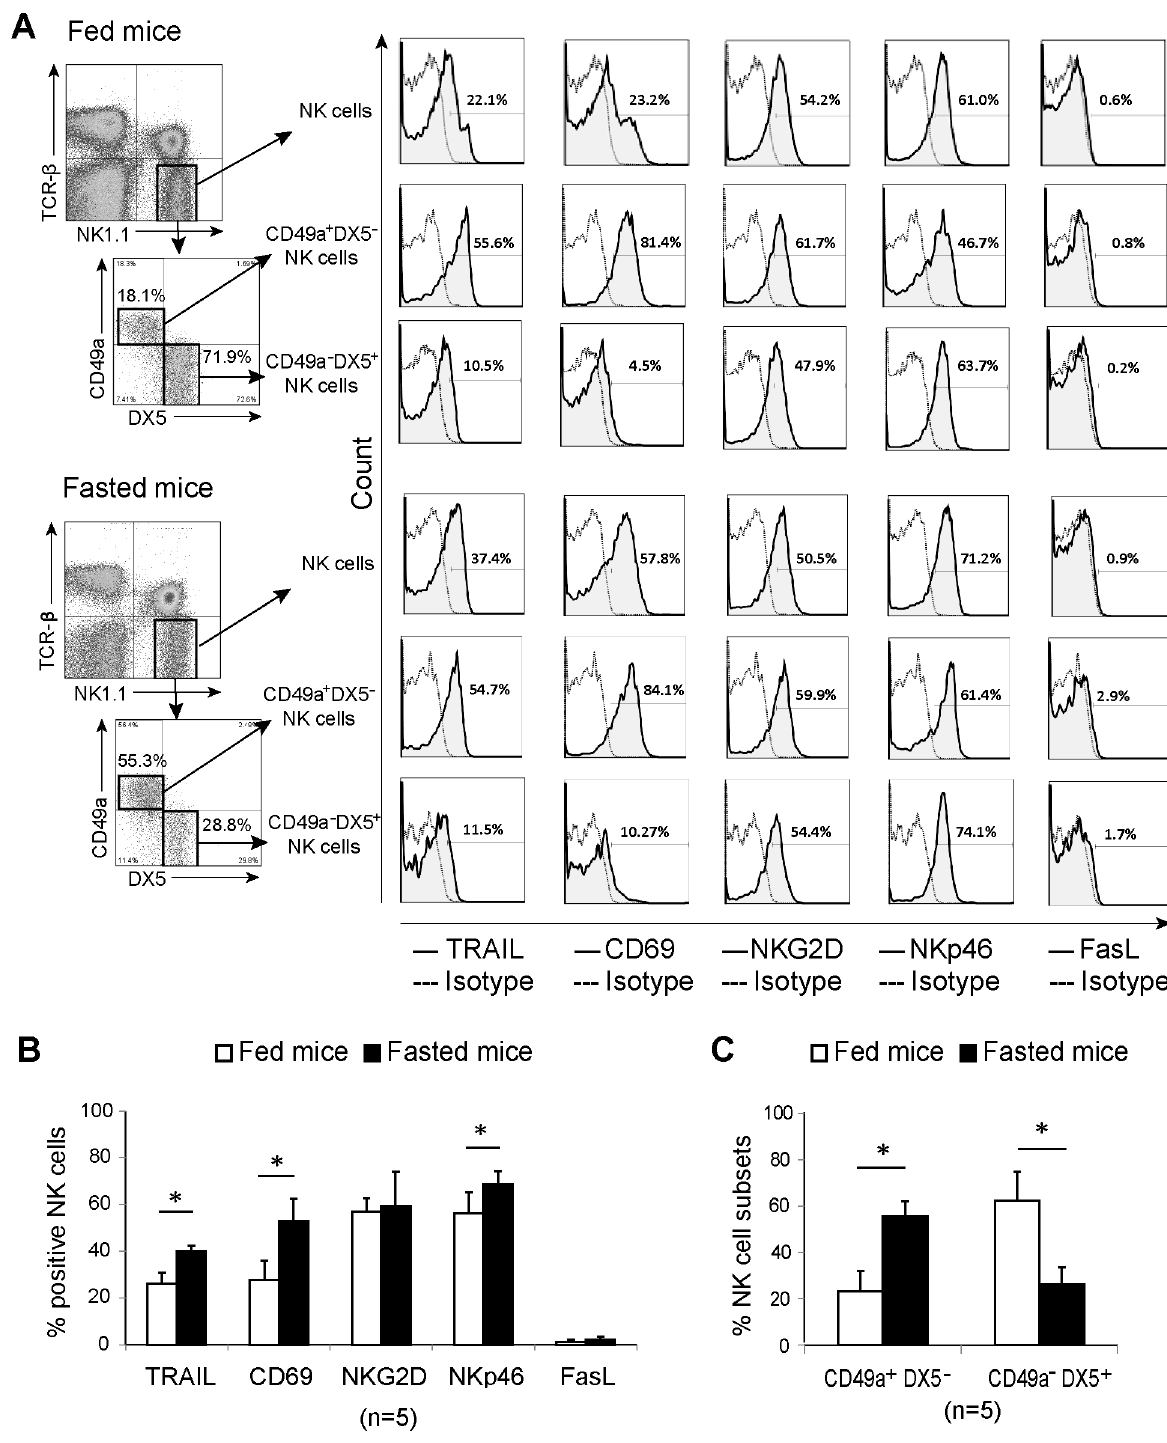
Figure 3. Analysis of functional markers in liver natural killer cells and their CD49a + DX5 2 and CD49a 2 DX5 + subgroups. Liver lymphocytes from fed and 3-day-fasted mice were simultaneously stained with monoclonal antibodies against DX5, CD49a, TRAIL, CD69, NKG2D, NKp46, and FasL. (A) Representative dot plots of gated TCR b 2 NK1.1 + natural killer (NK) cells and its two subsets, CD49a + DX5 2 and CD49a 2 DX5 + NK cells, in fed and fasted mice are presented. Histograms show the expression of TRAIL, CD69, NKG2D, NKp46, and FasL (solid lines) on whole NK cells and their subsets with the percentage of NK cells that are positive for those markers, dotted lines present negative control. (B) Bar graph shows the mean percentage plus standard deviation of NK cells that are positive for TRAIL, CD69, NKG2D, NKp46, or FasL. (C) The proportion of NK cell subsets, CD49a + DX5 2 and CD49a 2 DX5 + NK cells, in fed and fasted mice are shown as mean ratio plus standard deviation; * p , 0.05 as analyzed by the independent samples T test.